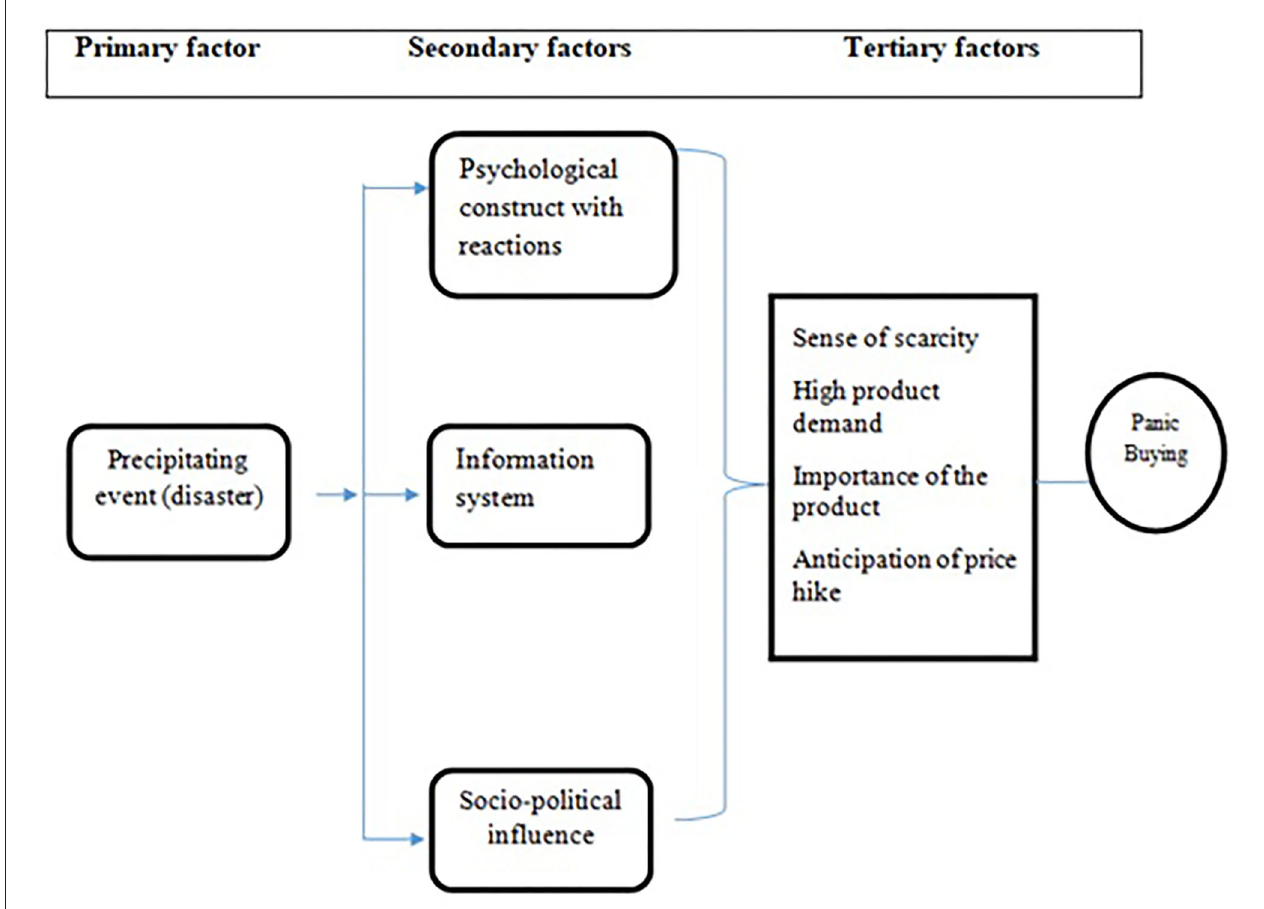
FIGURE 1 | Responsible factors for panic buying [adapted from